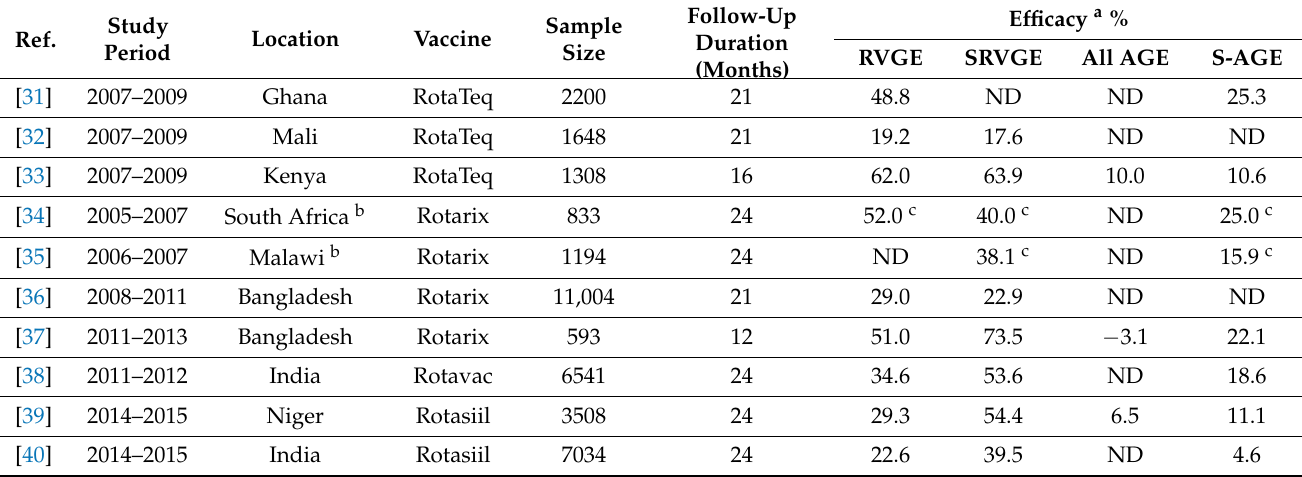
Table 2. Summary of vaccine efficacy trials from high-mortality countries (WHO mortality stratum D and